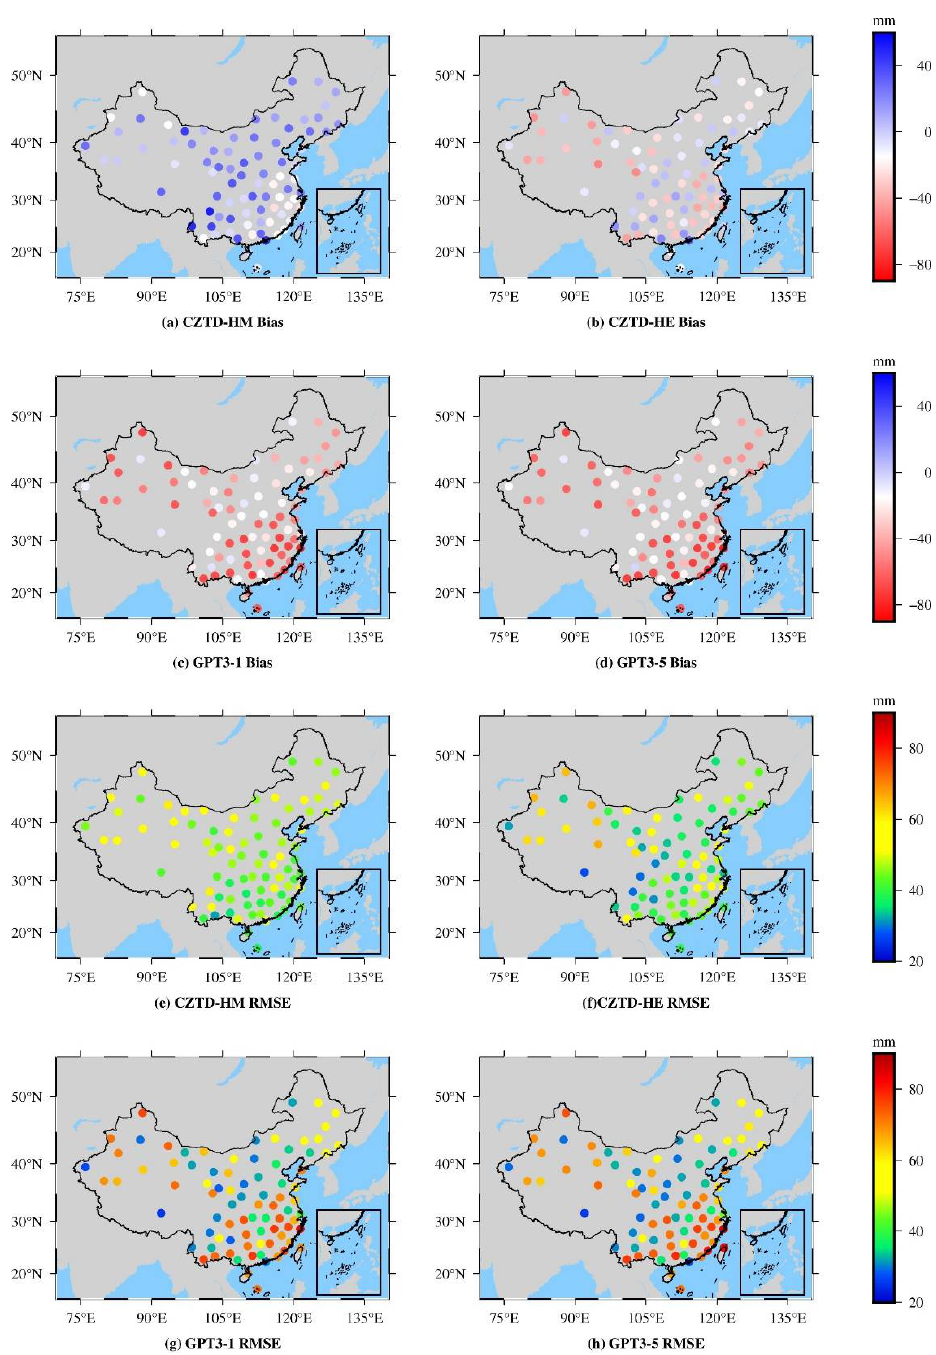
Figure 5. Distributions of the bias and RMSE of the ZTD layered vertical interpolation using different models compared with radiosonde data in 2017 for China .